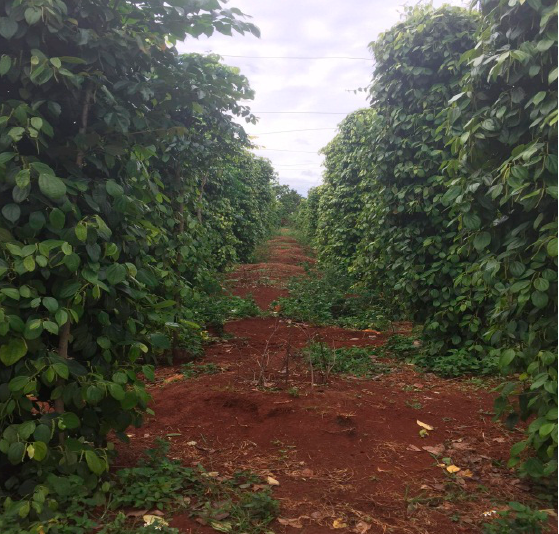
Figure 1. Black pepper farm (plants six-years old) at Dak Mil district, Dak Nong province, located in the Central Highlands of Vietnam.